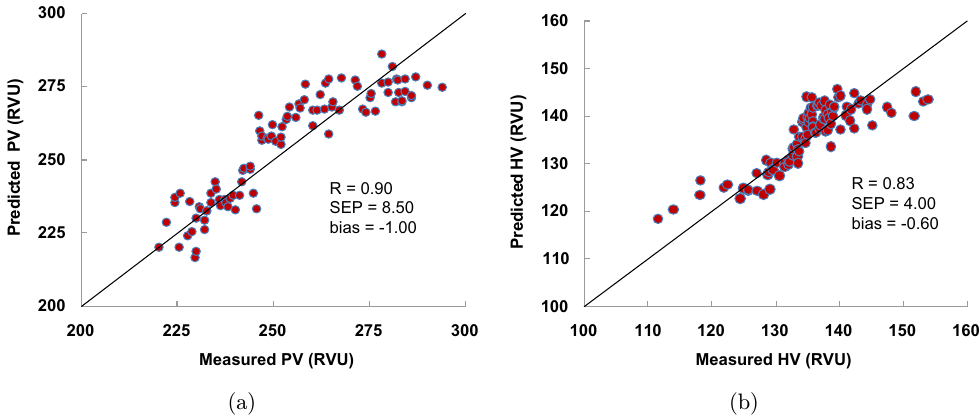
Fig. 5. Comparison of measured and predicted values of pasting properties by PLS model for validation set (a) peak viscosity (PV), (b) hot paste viscosity (HV), (c) cold paste viscosity (CV), (d) breakdown (BD), (e) setback (SB) and (f) consistency (CS)